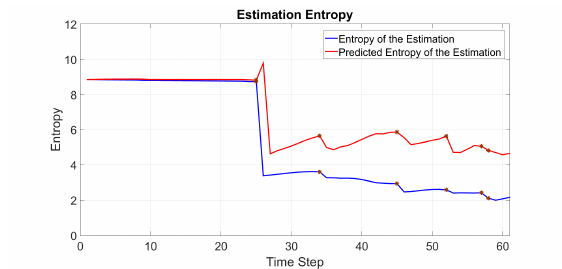
(d) Entropy of the estimated probability field.